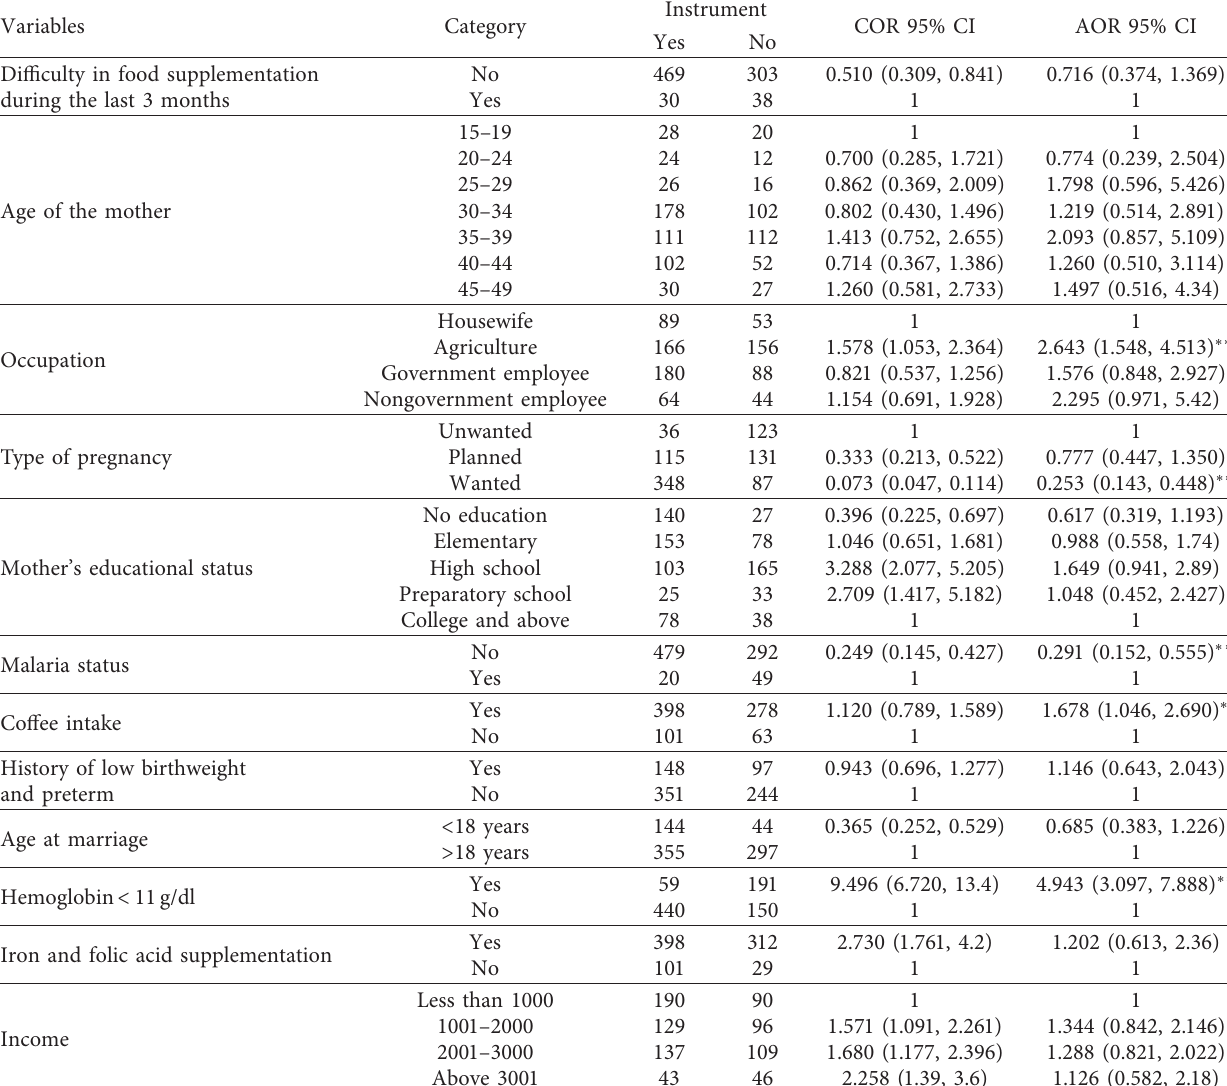
Table 3: Factors associated with undernutrition in pregnant women in public general hospitals of northern Ethiopia 2018 ( n � 840).